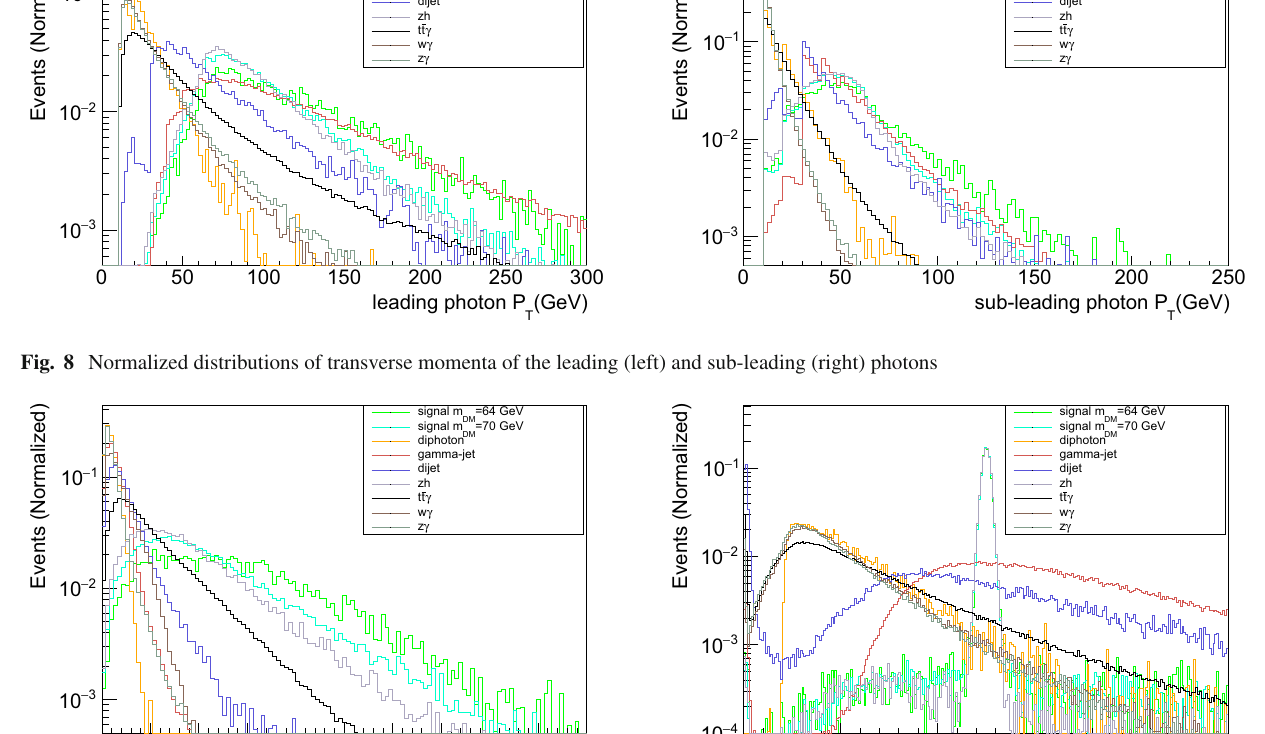
the ‘clean’ di-photon final state. Our analysis strategy goes beyondtheexistingones[13,14]evenatthelevelofrectangu-